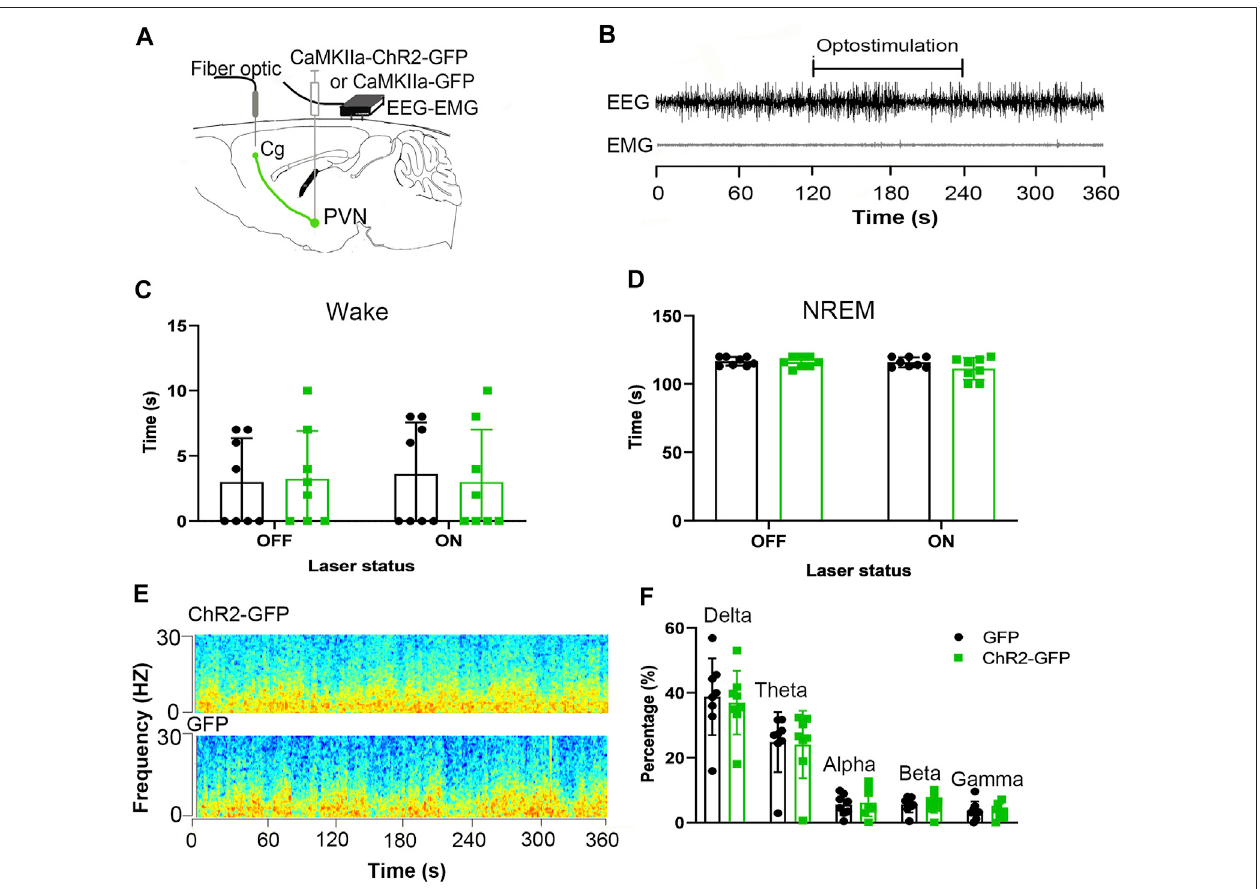
FIGURE 5 | Optogenetic activation of the PVN-Cg neural circuit doesn ’ t affect wakefulness. (A) Electroencephalogram (EEG) and electromyogram (EMG) traces during optogenetic stimulation of the PVN projections to the Cg. (B) EEG and EMG before, during, and after the 120s light stimulation. (C) Activation of the PVN projectionstotheCgdidnotaffectthewaketime. (D) ActivationofthePVNprojectionstotheCgdidnotaffecttheNREM time. (E) RepresentativeEEGpowerspectrum around 10 Hz stimulation delivered during NREM sleep. Color scale indicates the power (mV2) of raw power spectral density. (F) The percentage of delta, theta, alpha, beta, gamma of the EEG power had no signi fi cant differences (* p < .05, ** p < .01, *** p < .001, n = 8/group. Error bars denote SEM. Two-way ANOVA